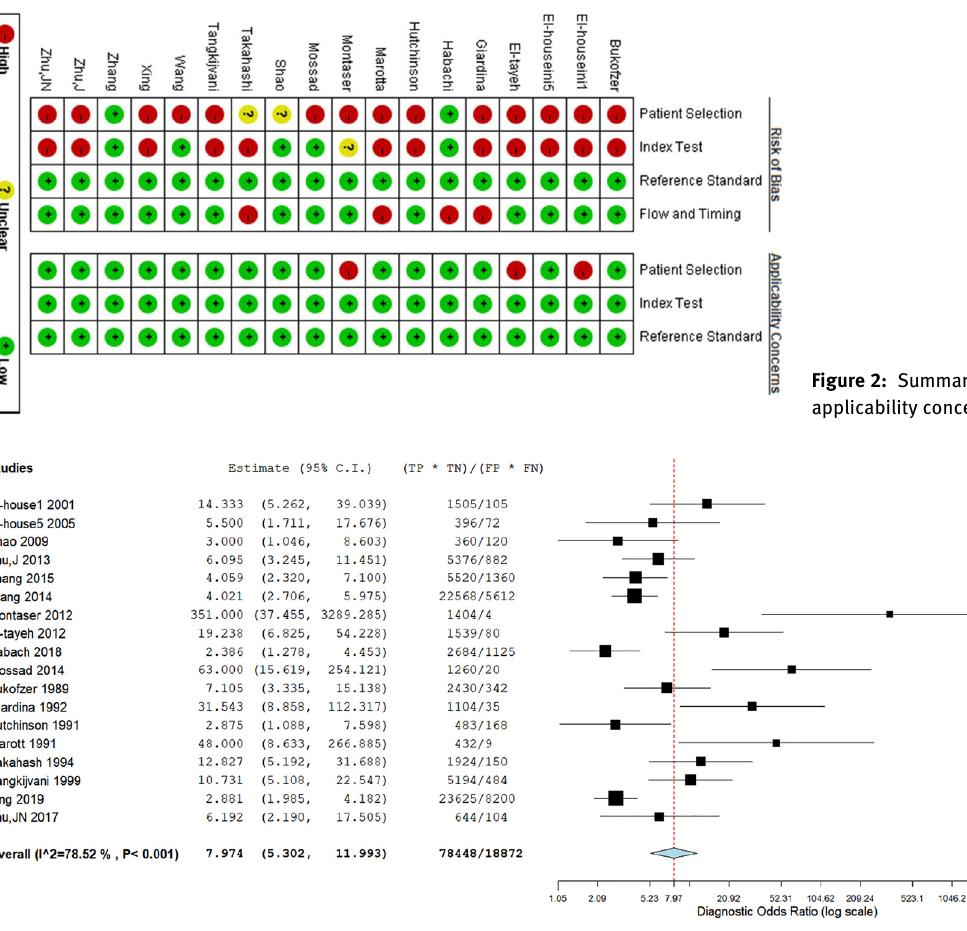
Figure 3: DOR forest plot for AFU.